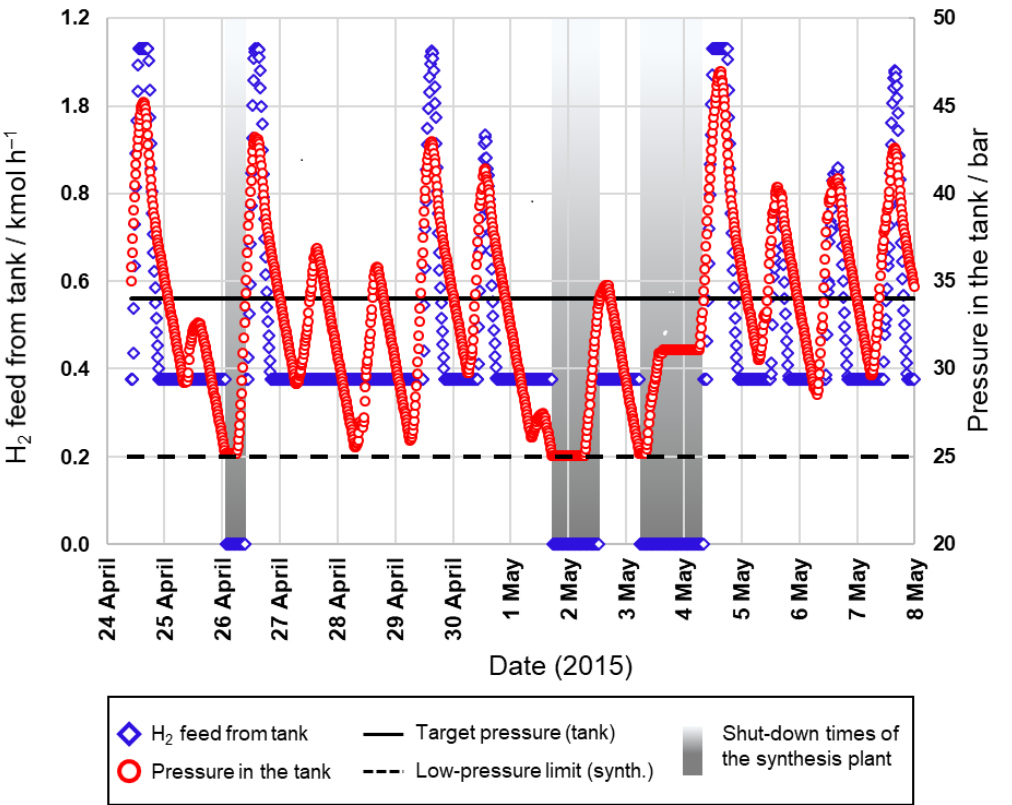
Figure 14. AspenDynamics results for hydrogen supply from the 50 m 3 hydrogen buffer tank and the pressure in the tank as a function of time with underlying PV data of two weeks in spring 2015. The scenario considers the dynamic operation of the electrolyzer and pressure-dependent control of the synthesis plant. Low pressure limit for running the synthesis plant: 25 bar.